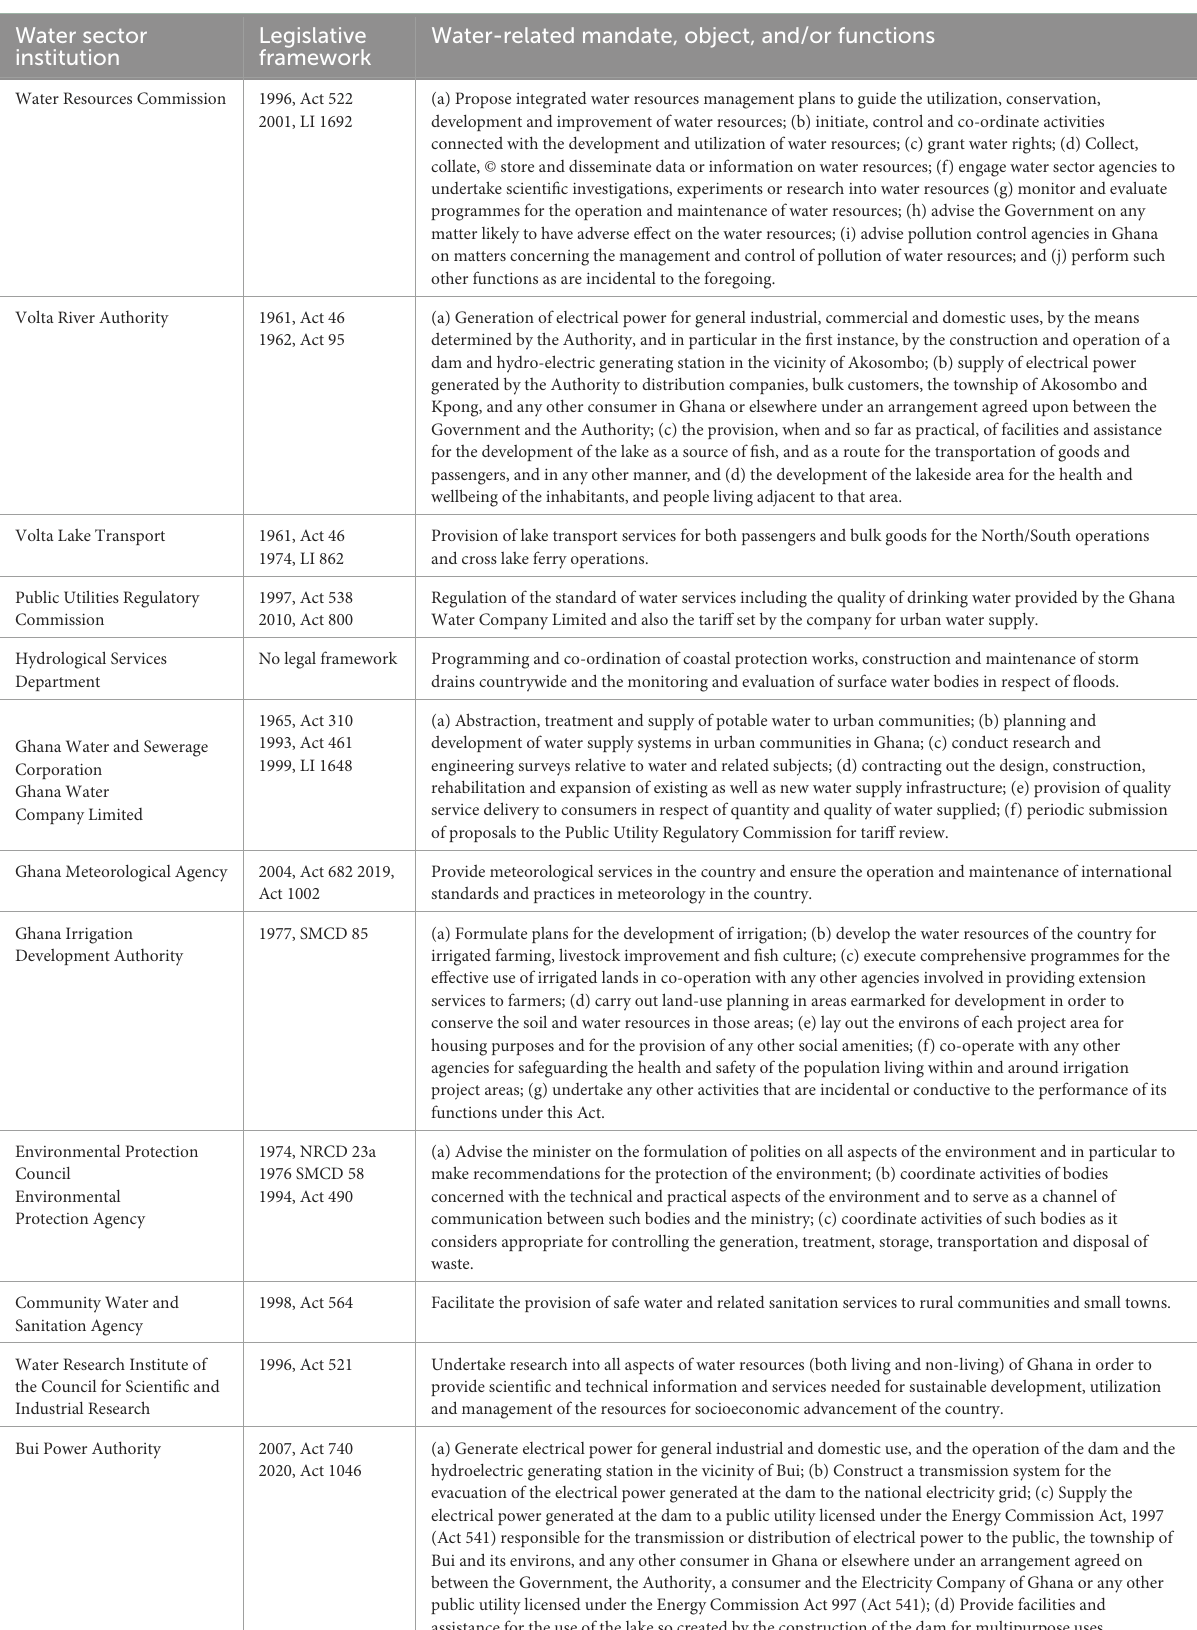
TABLE 5 Water sector institutions, their legislative frameworks and water-related mandate, object, and/or functions. Water sector